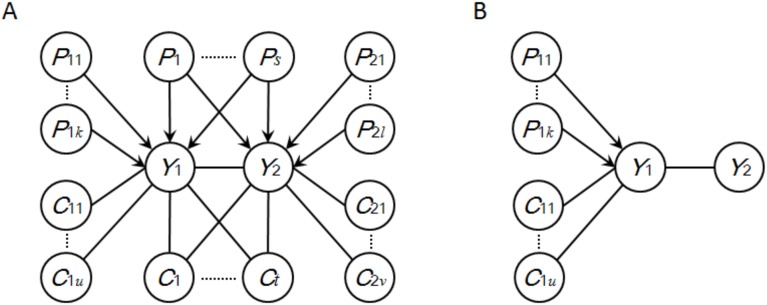
The general representations of resolvable LGPNs.
Y
1 and Y
2 are two correlated traits; P
1 = {P
11,…,P
1k} and P
2 = {P
21,…,P
2l} are, respectively, the unique parent nodes of Y
1 and Y
2; P
12 = {P
1,…,Ps} are the common parent nodes of Y
1 and Y
2; C
1 = {C
11,…,C
1u} and C
2 = {C
21,…,C
2v} are the unique neighboring traits of Y
1 and Y
2; C
12 = {C
1,…,Ct} are the common neighboring traits of Y
1 and Y
2. Note that each of the neighboring traits of Y
1 is nonadjacent to at least one of the parent nodes of Y
1, and the same is true of Y
2. Also note that P
1, P
2 and P
12 are allowed to have three different compositions: (1) a pure set of QTLs, if only genetic factors have been identified for Y
1 and/or Y
2; (2) a mixed set of QTLs and traits, if some traits in addition to QTLs have been determined to have causal effects on Y
1 and/or Y
2; (3) a pure set of traits, if only some traits have been found as causal factors of Y
1 and/or Y
2; in contrast, C
1, C
2 and C
12 only refer to those traits that are directly connected to Y
1 and/or Y
2 by an undirected edge. (A) The general representation of LGPNs where both Y
1 and Y
2 have parent nodes, and at least one of them has unique parent nodes; (B) the general representation of LGPNs where only Y
1 has parent nodes.